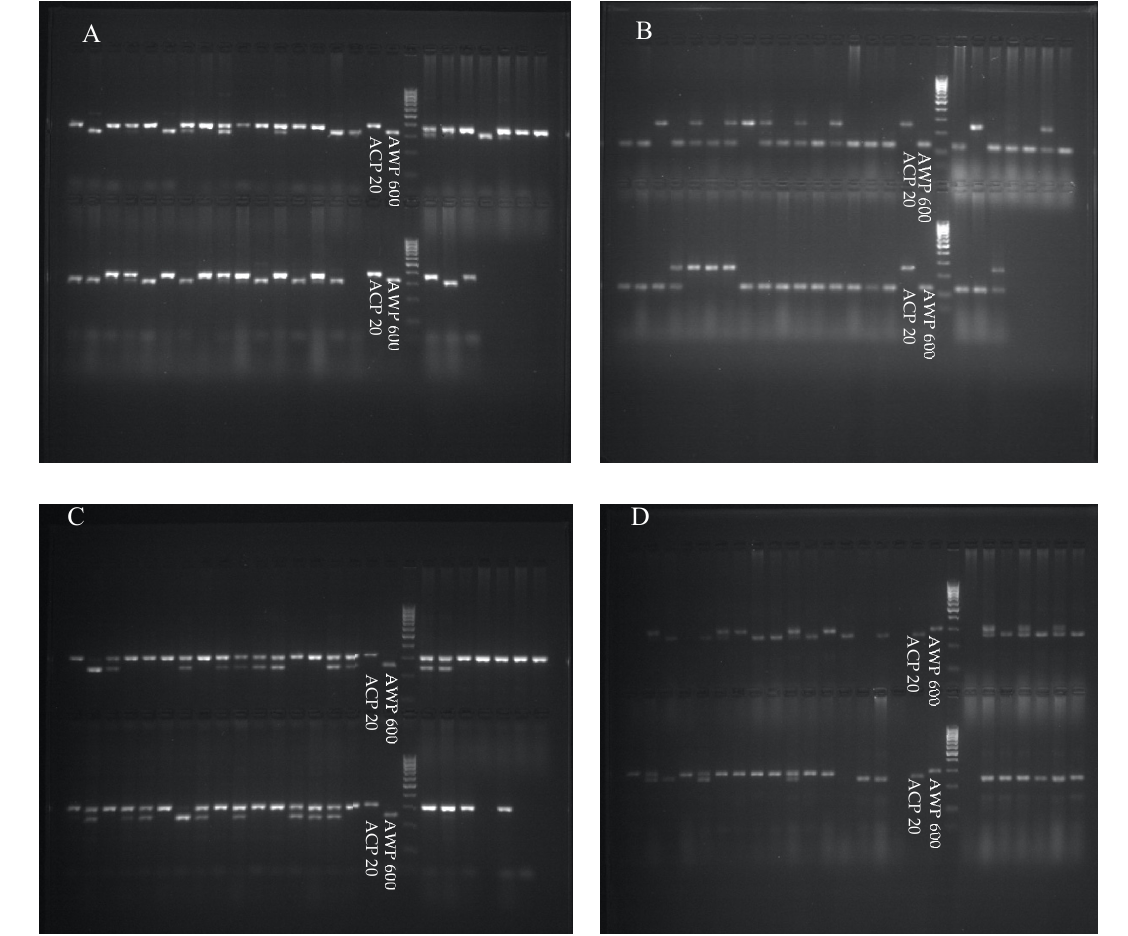
Figure 2. Agarose gel images of markers ( A ) AA67, ( B ) AD148, ( C ) AD270, and ( D ) AA285 between parents and F 4 lines derived from interspecific crosses involving P. sativum × P. fulvum . Table 3. Linkage group (LG), number of SSR markers, length (cM) and average marker distance (cM) of the linkage groups developed with 44 SSRs using F 4 lines involving P. sativum × P. fulvum . LGs Map Length (cM) No. of Markers